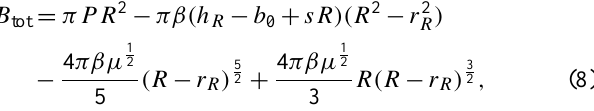
Figure 1. Cross section of the steady-state DAIS model solution for present-day Antarctic temperature, sea level and ocean subsurface